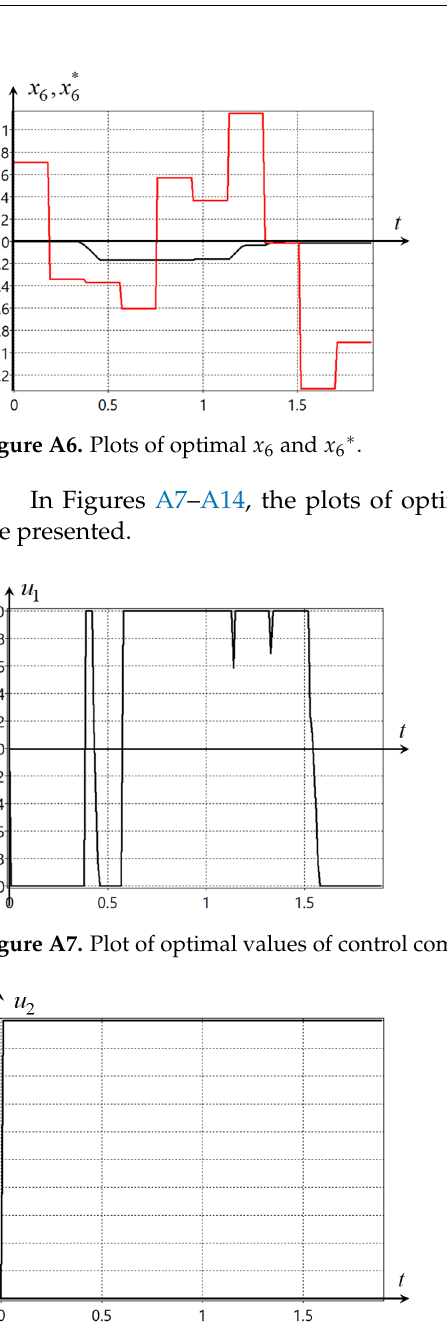
Figure A8. Plot of optimal values of control component u 2 .